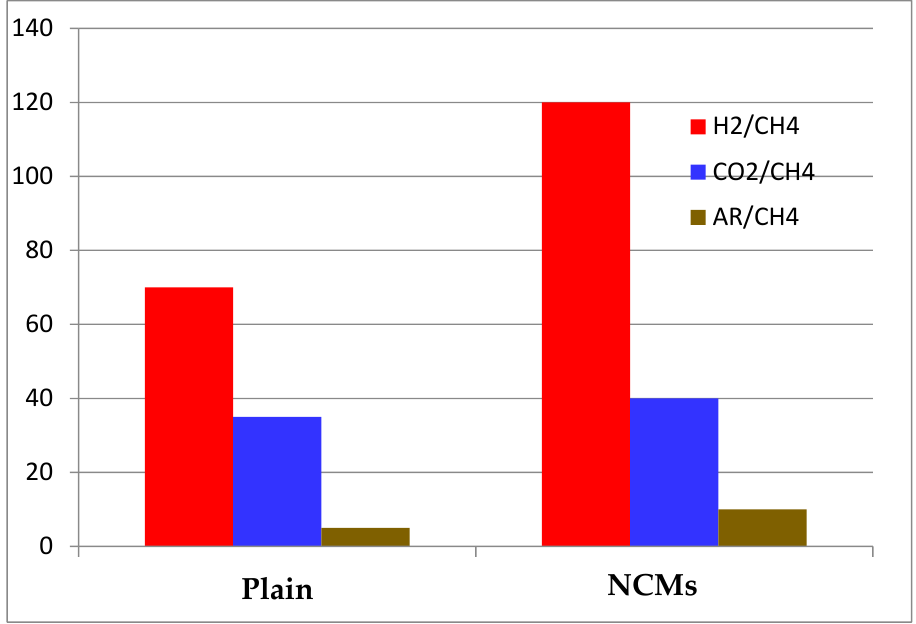
Figure 10. NCMs (ZIF-8) and plain Na-Alg membranes permeated by various gas molecules.